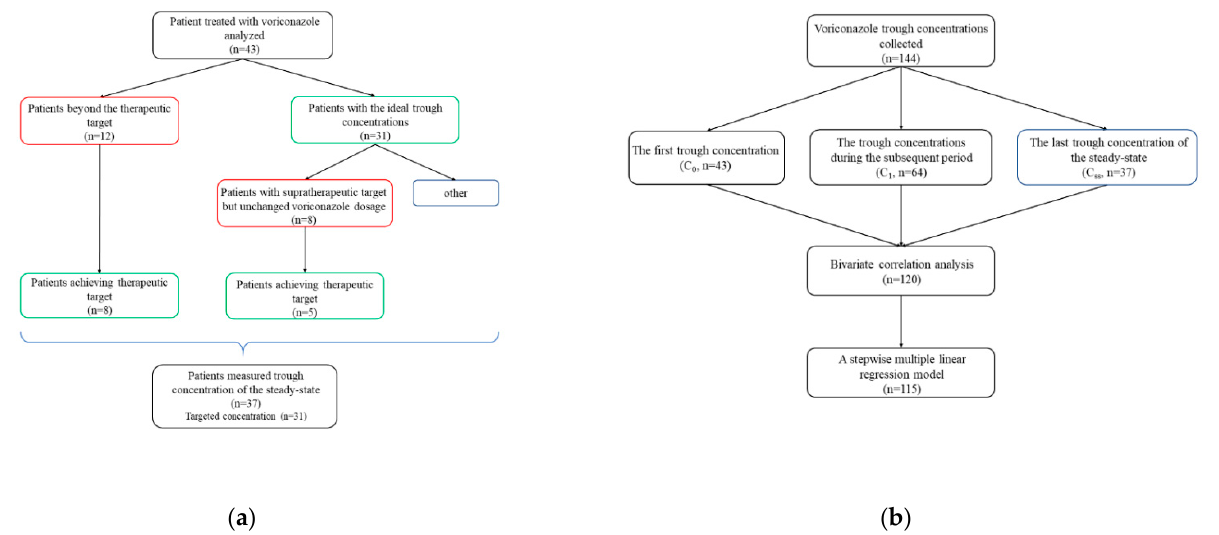
Figure 1. The flow charts show ( a ) changes of voriconazole trough concentrations in 43 patients during treatment clinically; ( b ) statistical analysis of 144 measured voriconazole trough concentrations. Table 1. Demographic, clinical data and voriconazole regimen for 43 CP-C patients with therapeutic drug monitoring of voriconazole.